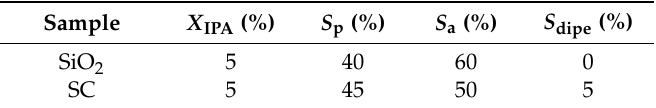
Figure 4. Raman spectra in the range 150–1000 cm − 1 : ( A ) SiO 2 –C sample; ( B ) SiO 2 –C sample treated 24 h at 250 °C in liquid water. Table 3. Conversion of isopropanol (IPA) ( X IPA ) and selectivities to propylene ( S p ), acetone ( S a ), and di ‐ isopropylether ( S dipe ) in IPA decomposition reaction at 200 °C.